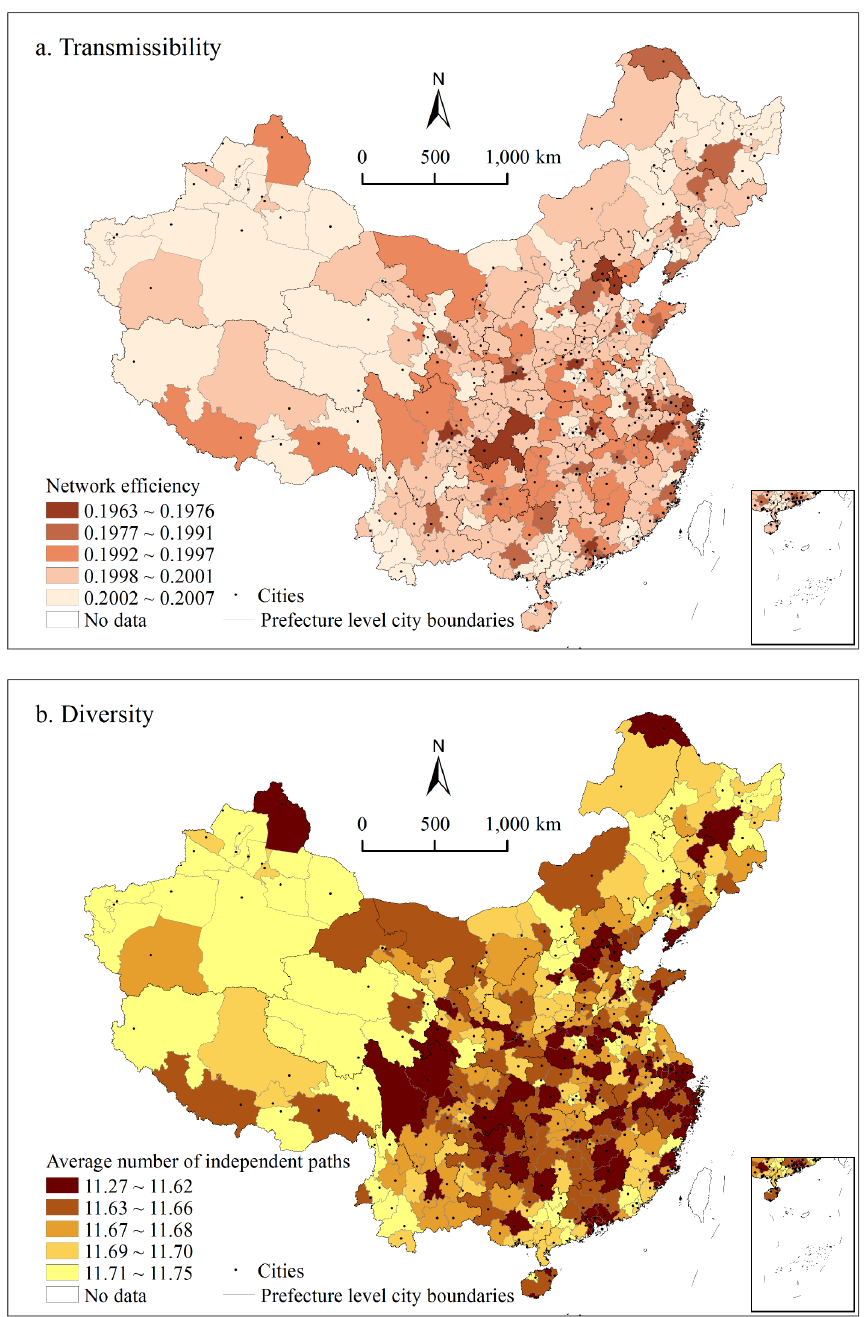
Figure 9. Comprehensive network’s ( a ) transmissibility and ( b ) diversity after node failure.